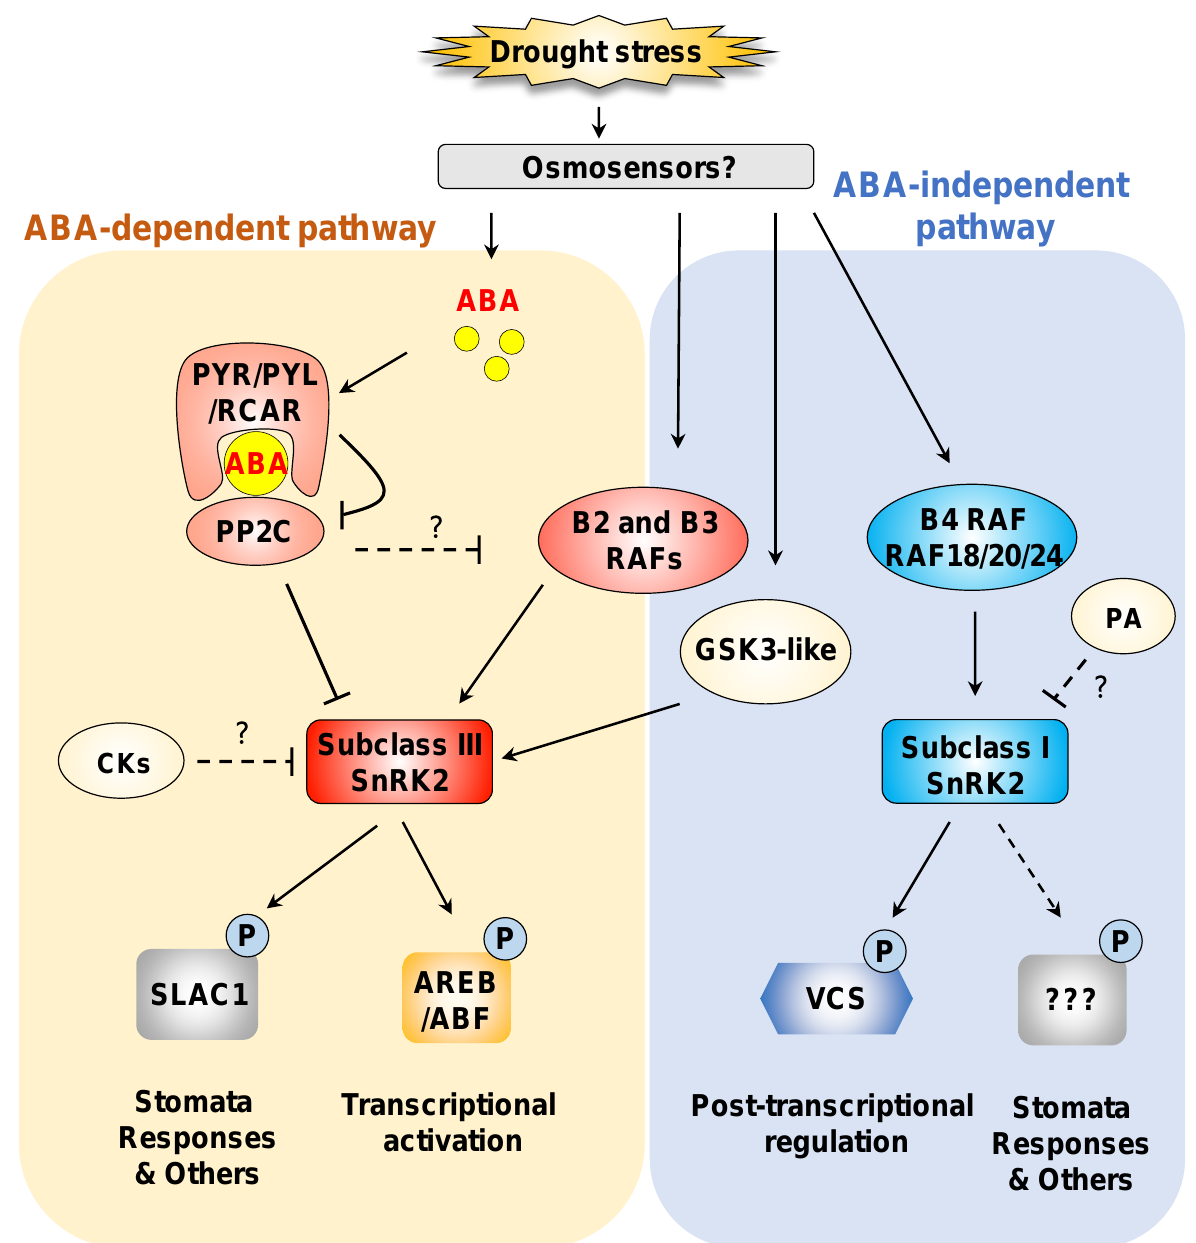
Figure 1. SnRK2-mediated drought stress signaling and gene expression. Subclass III SNF1-related protein kinases 2 (SnRK2s) play key roles in abscisic acid (ABA) signaling under osmotic stress. Negative regulation of subclass III SnRK2s is released via inhibition of protein phosphatases 2C (PP2C) by ABA-pyrabactin resistance1/pyr1-like/regulatory components of ABA receptor (ABA-PYR/PYL/RCAR) complexes under osmotic stress. Subclass III SnRK2s are phosphorylated and activated by B-type Raf-like kinases and GSK3-like kinases in an ABA-independent manner. Activated subclass III SnRK2s phosphorylate a variety of substrates, including ABA-responsive element binding proteins/ABA-responsive element binding factor (AREB/ABF), to induce the expression of stress-responsive genes. ABA-unresponsive subclass I SnRK2s are quickly activated in response to osmotic stress in an ABA-independent manner. Osmotic stress-activated subclass I SnRK2s regulate mRNA decay by phosphorylating the mRNA-decapping activator VCS. The B4 Raf-like kinases RAF18, RAF20 and RAF24 are responsible for the activation of subclass I SnRK2s. Dashed lines indicate possible but unconfirmed routes. One of the phosphorylation targets of subclass III SnRK2s is the group A bZIP